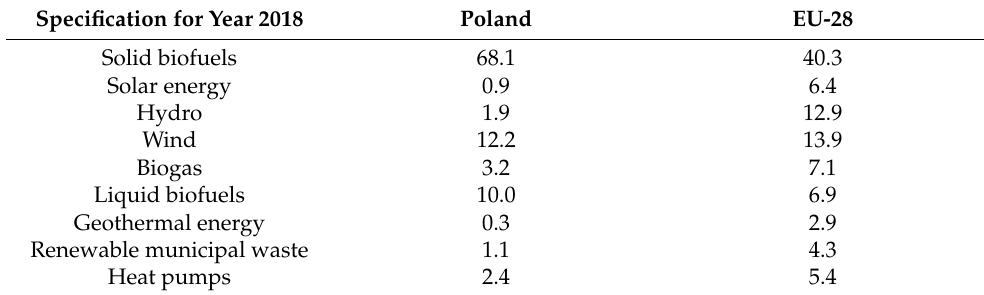
Table 7. This is a specification of the contribution for renewable energy sources for Poland and the EU-28 (in